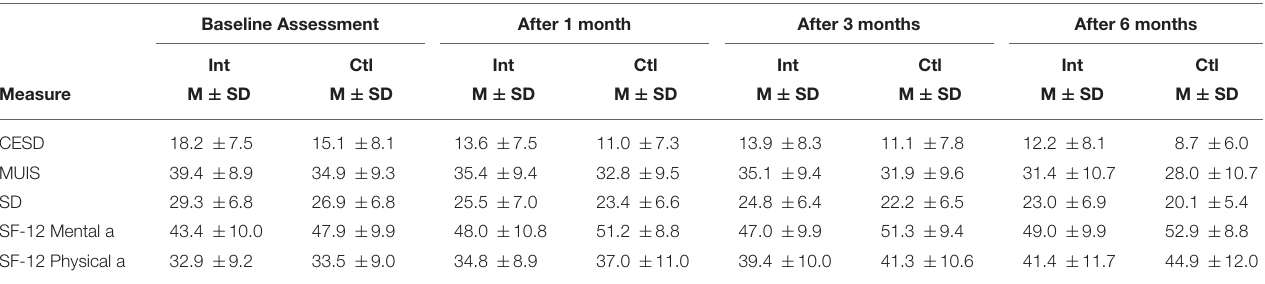
TABLE 3 | Measure of unadjusted quality of